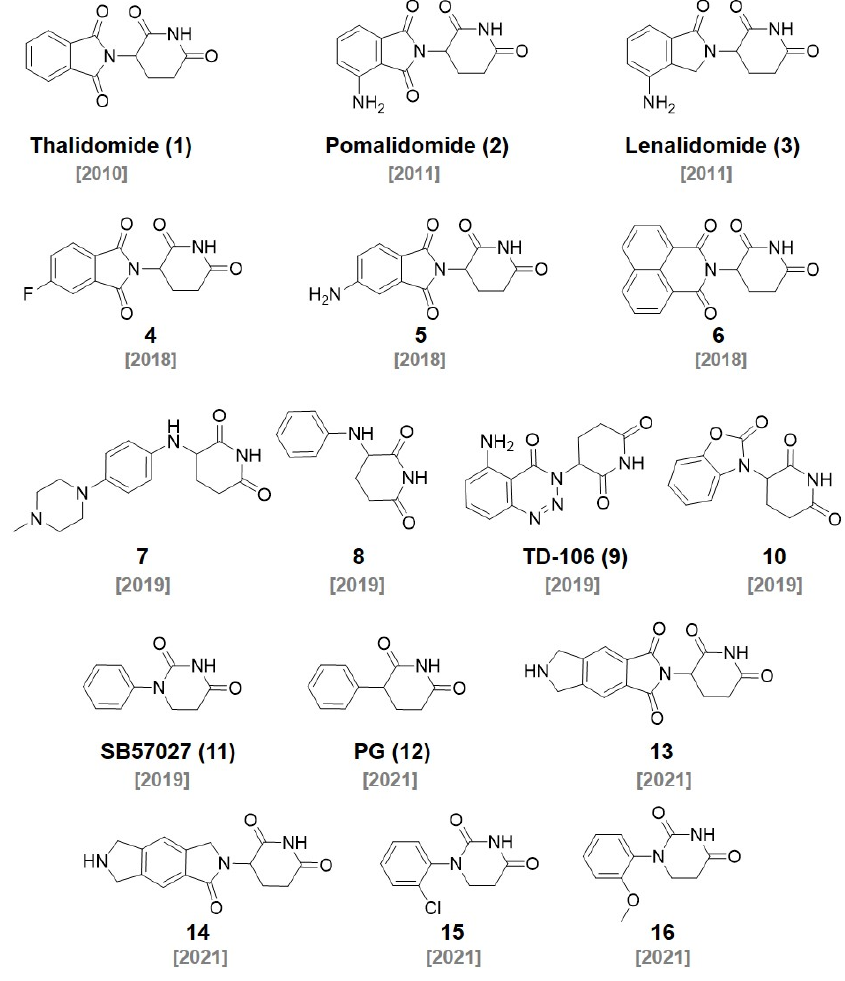
Figure 1. Chemical structures of CRBN ligands and their derivatives.